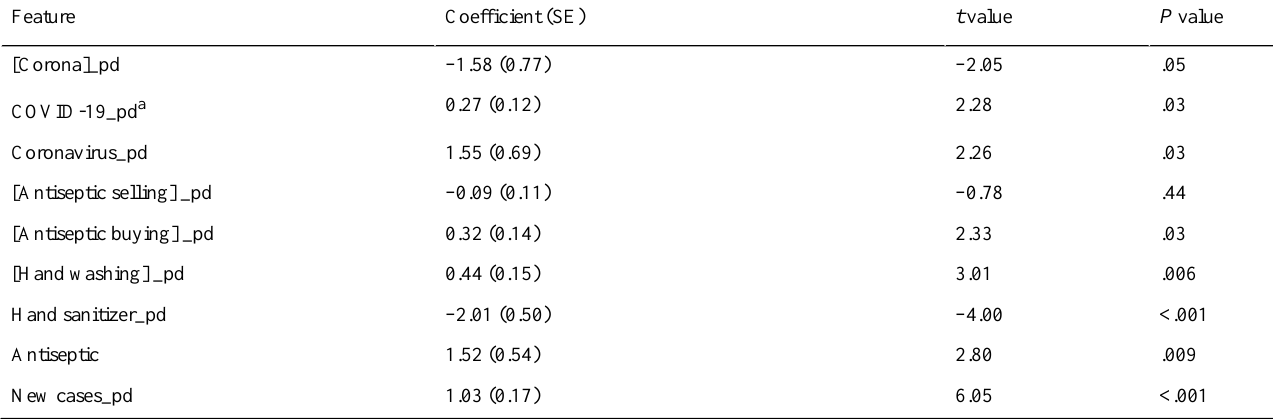
Table 2. Features’effect on new daily cases in the linear regression